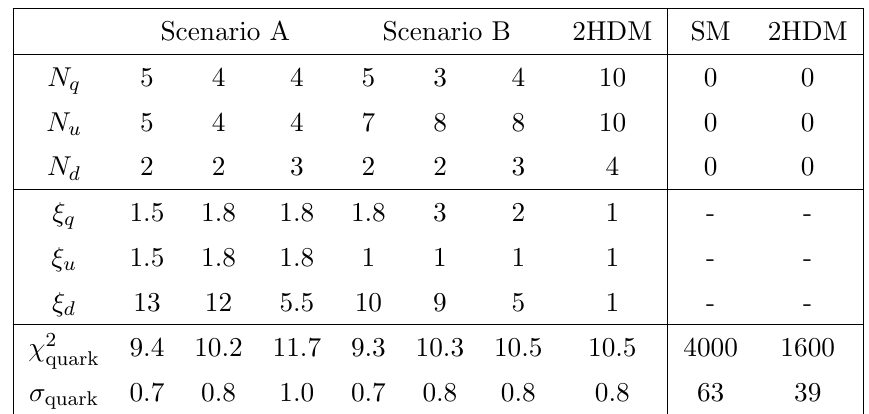
Table 1. Values of (cid:31) 2 for several choices N q;u;d and (cid:24) q;u;d . The ten degrees of freedom involved in the computation of (cid:31) 2 are the six quark masses, the three mixing angles and the Jarlskog invariant J . For the 2HDM we set tan (cid:12) = 40.